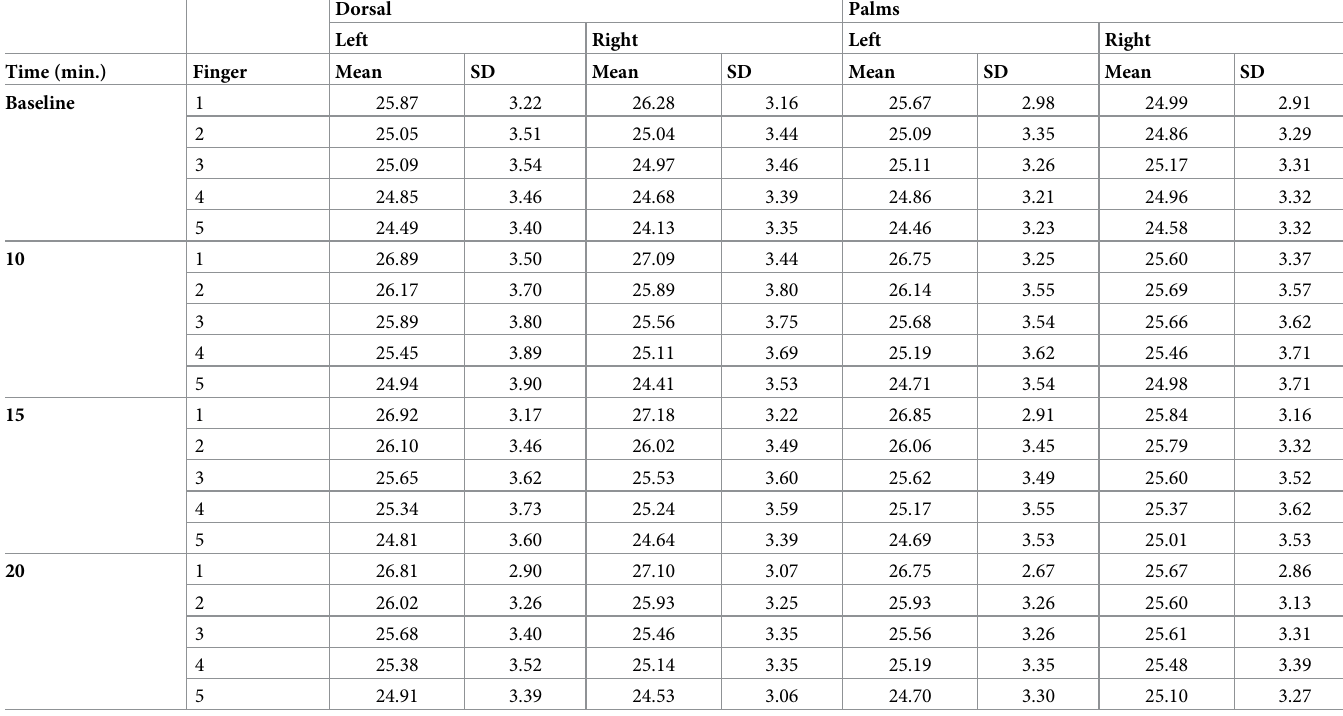
Table 4. Average temperatures of the finger, dorsal and palmar regions. Dorsal Palms Left Right Left Right Time